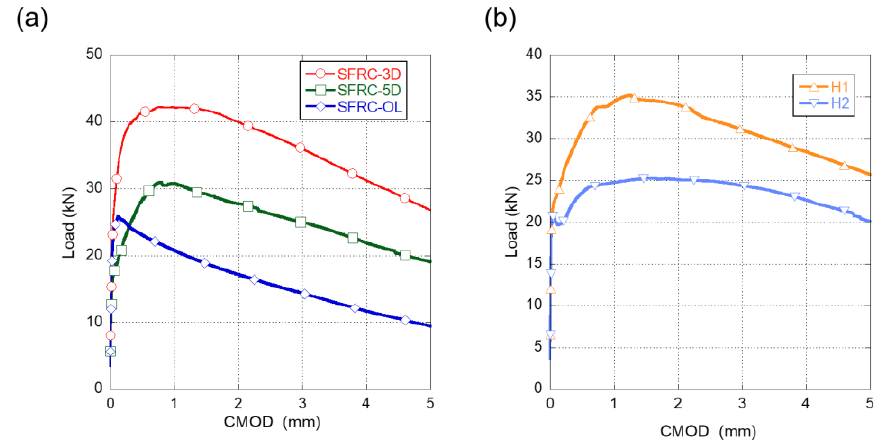
Figure 2. ( a ) Fracture test results of SFRC-OL, SFRC-3D, and SFRC-5D. ( b ) Fracture test results of H1 and H2.